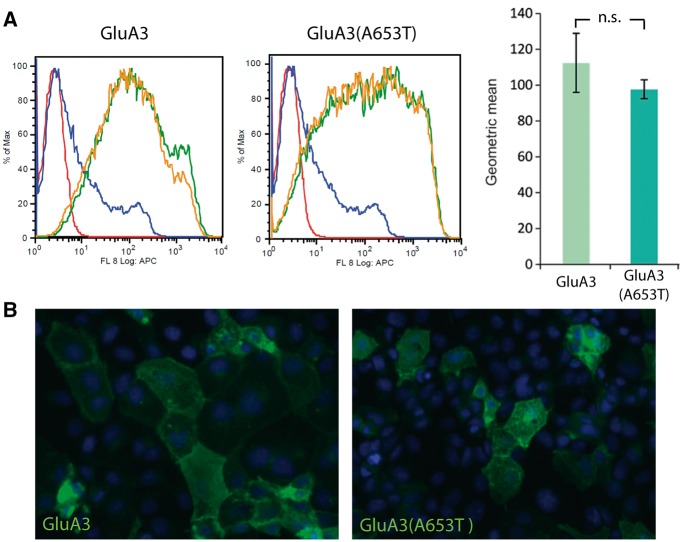
The GluA3 A653T mutation does not interfere with channel trafficking. (A) Raw FACS profiles demonstrating membrane localization of GluA3 (left panel) and GluA3(A653T) (right panel) in transfected HEK293T cells (duplicate experiments shown by green and orange traces, untransfected and unstained cells shown by red traces and untransfected and stained cells shown by blue traces). Geometric mean expression values are shown in the histogram and were compared with a t-test on the log of the observations; error bars: standard error of the mean (S.E.M.). (B) Immunohistochemical staining of Cos7 cells transfected with GluA3 (left panel) and GluA3(A653T) (right panel) showing membrane localization of the receptor.